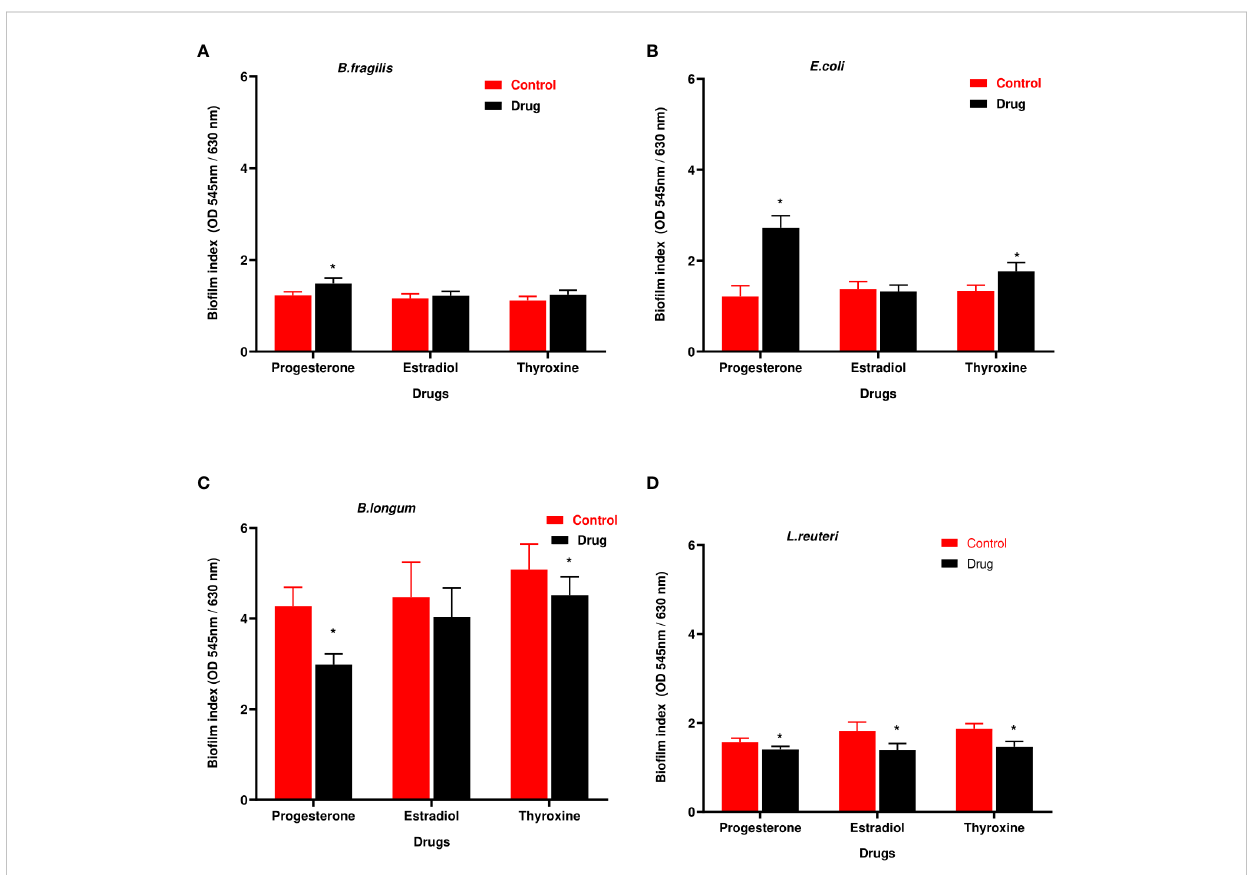
FIGURE 4 Bio fi lm formation ability of selected bacteria under the effect of hormonal drugs. Change in bio fi lm formation index by (A) B. fragilis ; (B) E. coli (C) ; B. longum; (D) L. reuteri with hormonal drugs. Values were expressed as the mean of the percentage of three experiments with error bars (SE). Tested hormonal drugs include progesterone, ethinyl estradiol, and L-thyroxine in their intestinal concentrations, 211.99, 0.562, and 0.0481µM, respectively. Control represents the bacteria grown in culture with DMSO. Multiple unpaired t-test along with Holm-S ̌ ı ́ da ́ k for multiple corrections was used to statistically compare the effect of different drugs on bacterial bio fi lm. * Signi fi cant difference